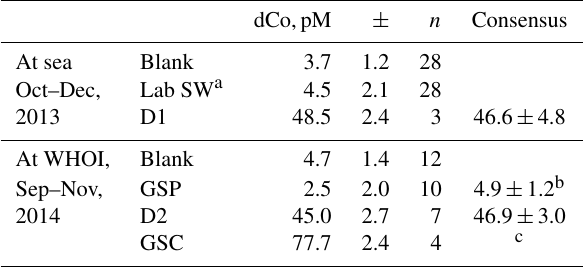
Table 1. Blanks and standards used during analyses. dCo,pM ± n